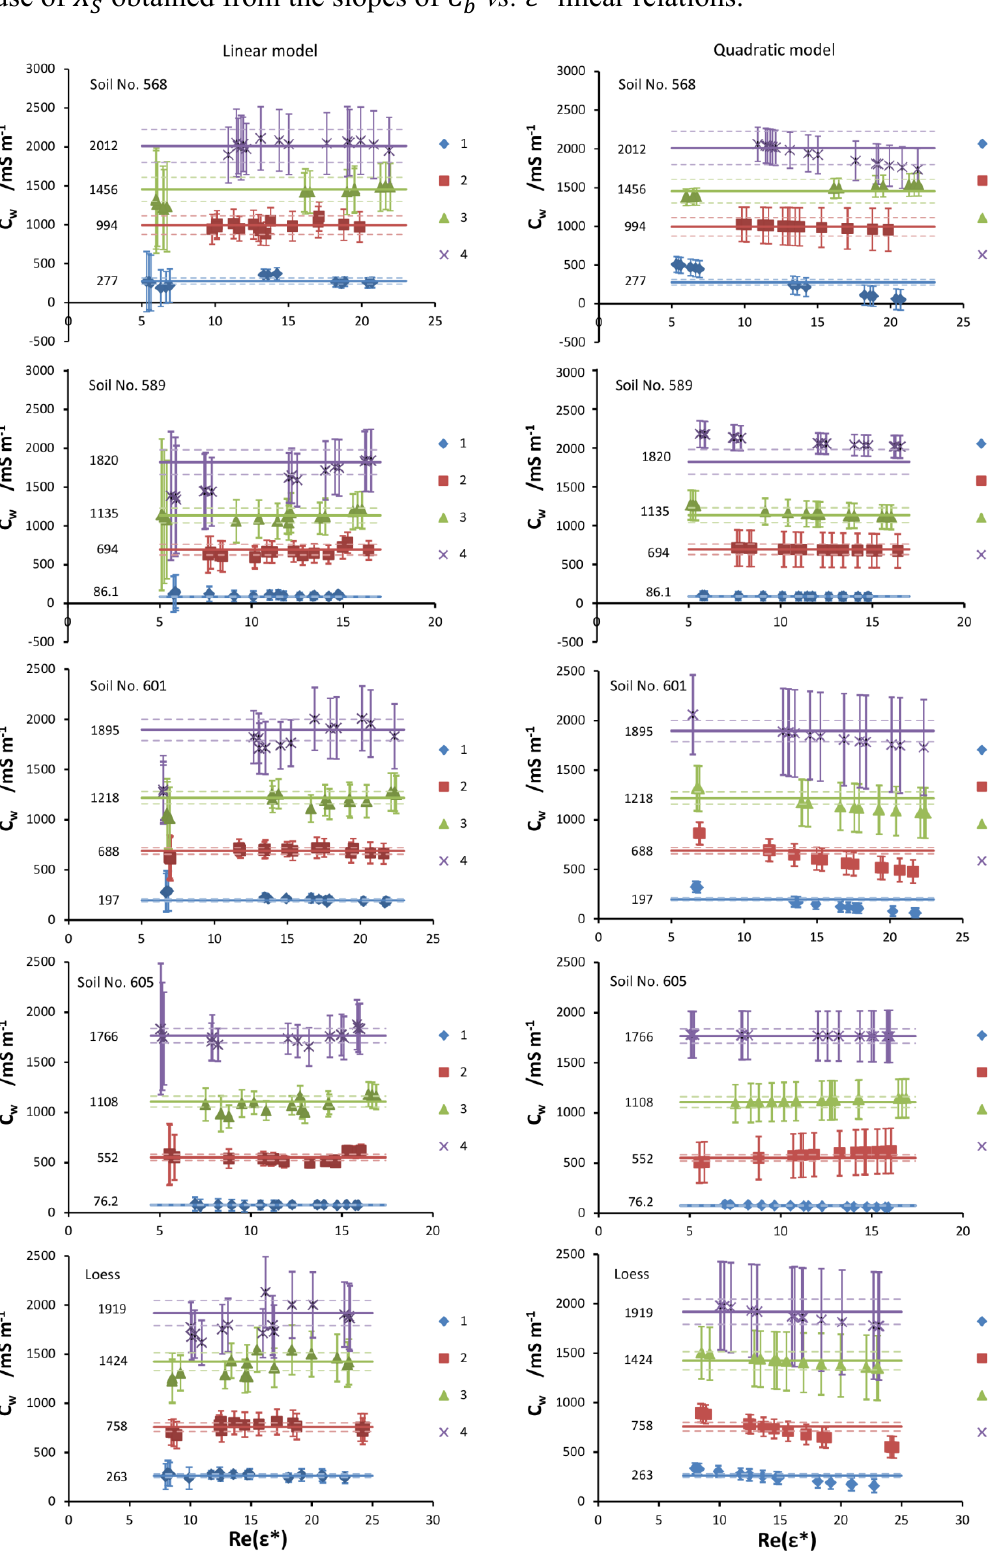
versus (cid:2013) (cid:4593) (cid:3404) Re(cid:4666)(cid:2013) (cid:1499) (cid:4667) for linear and quadratic salinity (cid:3050) values calculated with (cid:3050) vs. (cid:2013) (cid:4593) linear (cid:3029)